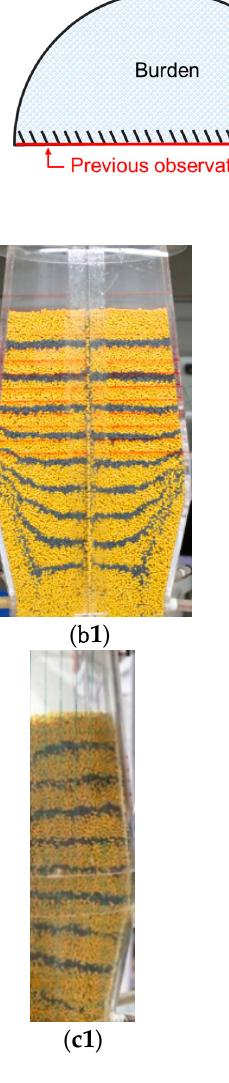
Figure 3. ( a ) The section observation by the cutting method in the 3D half-circle BF model. The distributions of burden particles and tracer particles observed through the flat wall ( b1 ) and the internal surface after the cutting method ( c1 ) in the experiment. Similarly, the flat wall ( b2 ) and the internal surface ( c2 ) simulated by sector model 2 and sector model 1,